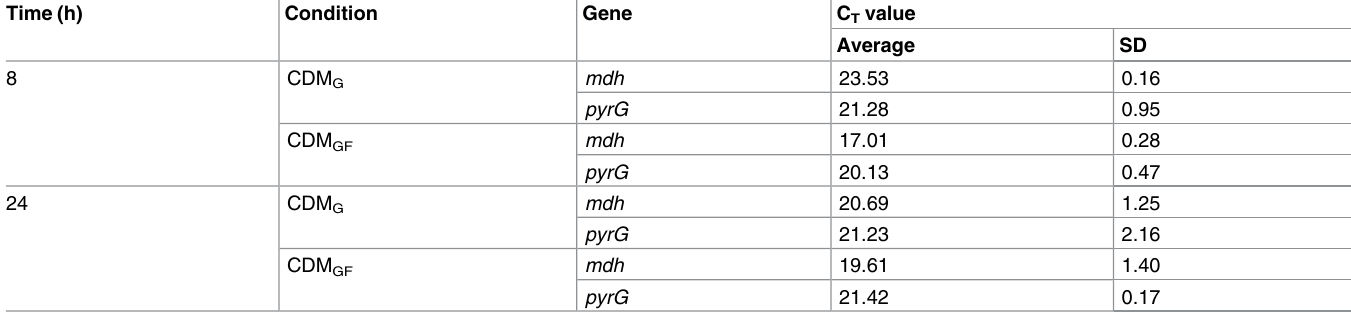
Table 1. C T values of mdh and pyrG genes of L . reuteri CRL 1101 grown in CDM in absence and presenceof fructose (CDM G and CDM GF ) for 8 and 24 h. Time (h)